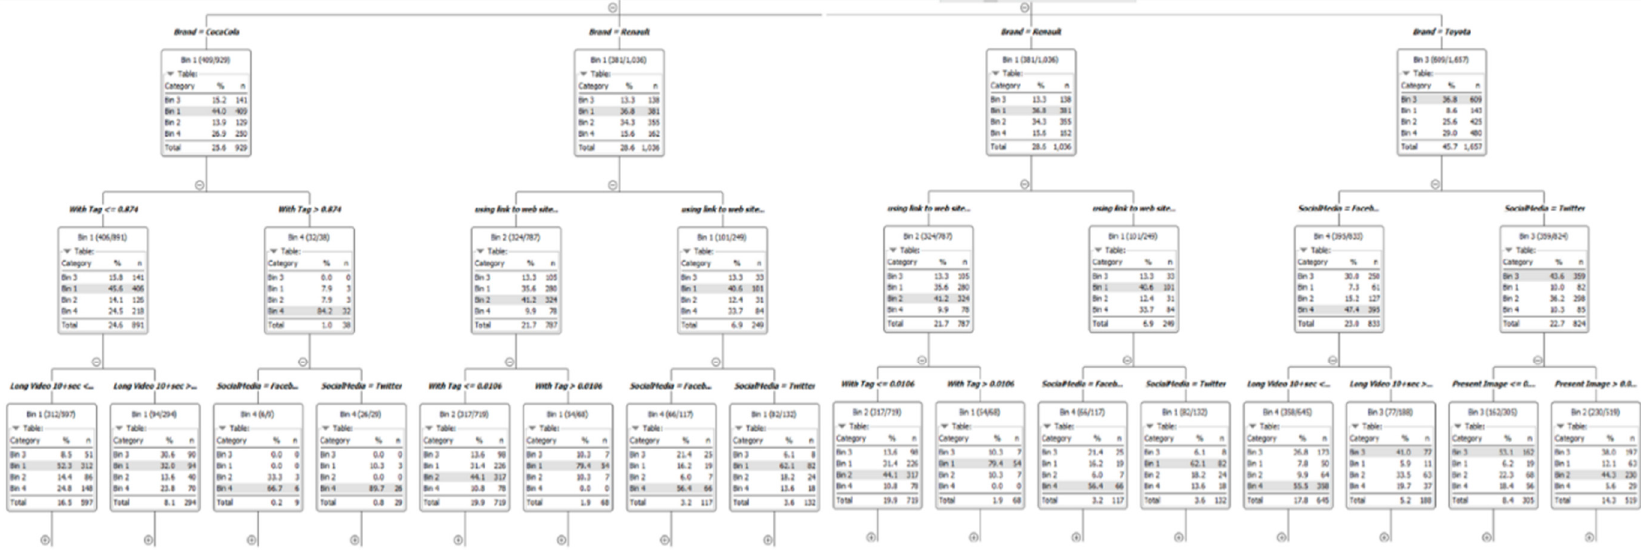
Figure A1. Decision Trees.